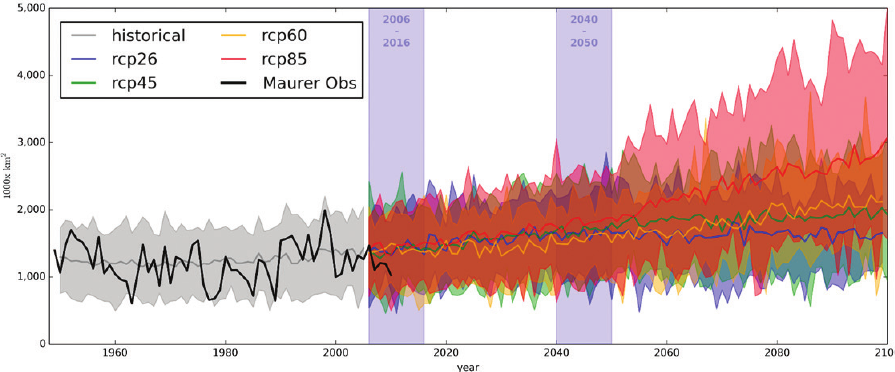
Figure 4. Amount of suitable habitat for coypu by year starting in 1950 and extending to 2100. Amount of suitable habitat is defined as thousands of km 2 within the continental USA without any months where average minimum temperature was <0 °C while average maximum temperature was also <5 °C. The solid black line from 1950 to 2013 is the Maurer observed dataset, the historical data is the 12 General Circu- lation Models (GCMs) calibrated between 1950 and 2013 using the Maurer dataset, and the projected climate by the GCMs with the average amount of predicted suitable habitat (solid line) and variation in predicted suitable habitat (solid colored area) for the four different representative concentration pathways (RCPs) describing possible climate futures by the GCMs. The solid vertical bars indicate the time periods for which we created geographic maps of predicted suitable